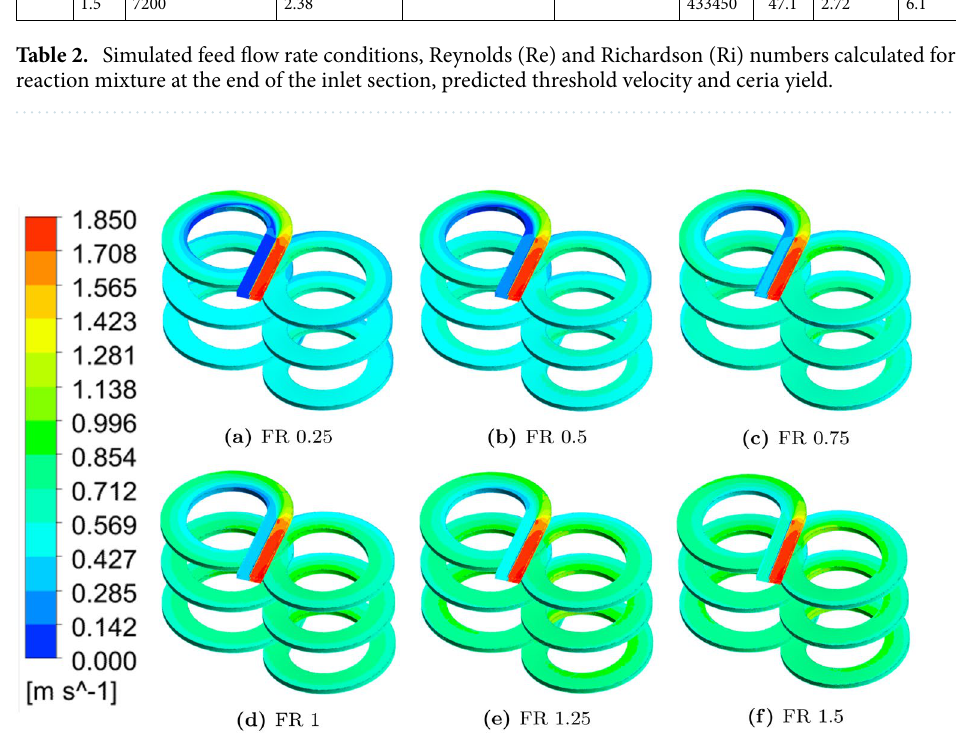
Figure 4. Contour plots of reaction mixture velocity with different flow ratios for the flow set FS1. Images used courtesy of ANSYS,